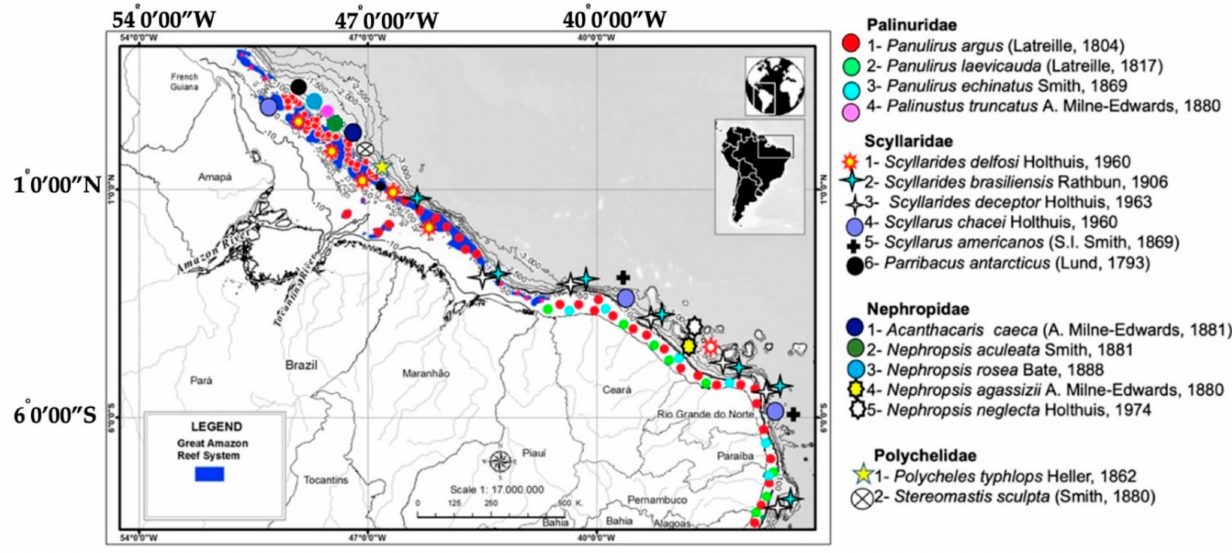
Figure 2. Spatial distribution and diversity of lobsters in Great Amazon Reef System (GARS) and in northeastern section (NE) of continental shelf of Brazil